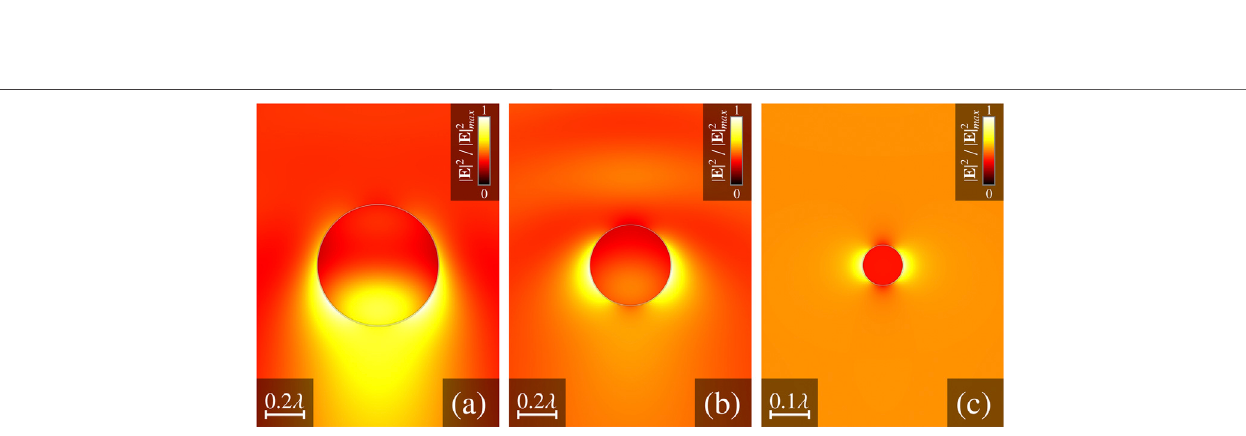
scatterer, the light can propagate only on a surface in a thin skin layer. In case the scatterer is large, the surface can be considered locally as a plane, each point of which is illuminated by a superposition of the p-polarized and s-polarized waves. The p-polarized wave generates TM